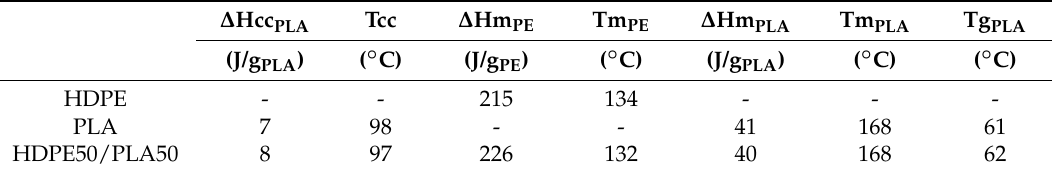
Table 4. Differential scanning calorimetry (DSC) results for HDPE, PLA, and HDPE50/PLA50.